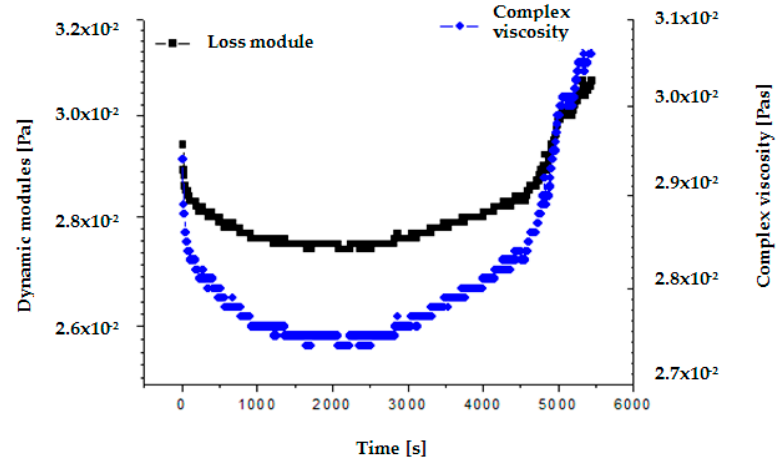
Figure 15. Loss module and complex viscosity for EM_5c measured at 24 h after manufacturing.